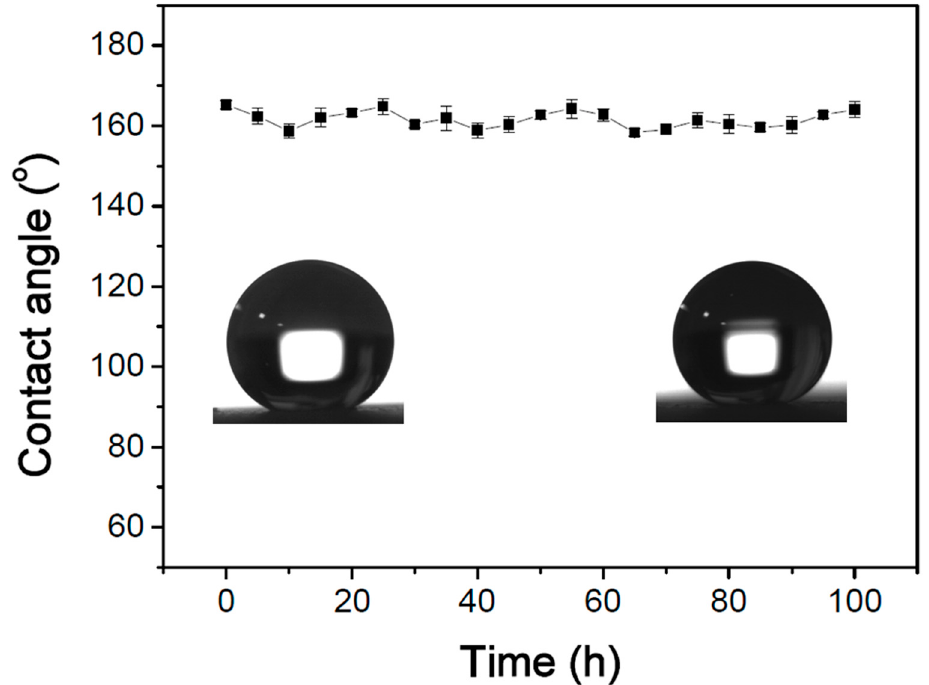
Figure 5. Stability of the superhydrophobic CNT / polybenzoxazine film. The value of contact angle of water as a function of ultraviolet (UV) illumination time.